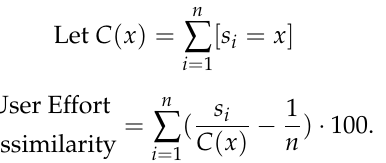
Figure 4. Acceleration data recorded from scenes i–iii: the top row displays group median averages (1), with individual user data shown below (2). The final row aligns the peak cluster periods detected along the x -axis (3). A high-resolution version of the image is available in the Supplementary Material. We formulate the following clustering features: Peak Density, the total number of peaks detected relative to the duration of the cluster, and User Effort Dissimilarity, based on an equal alteration of active